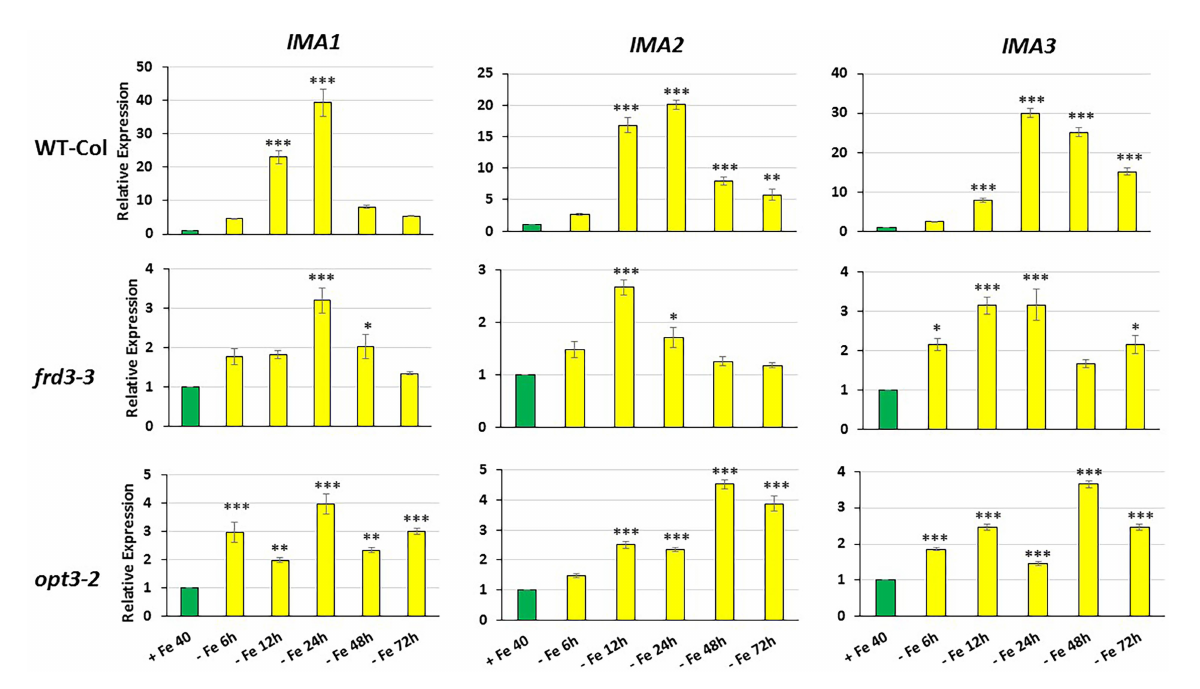
FIGURE 1 Time course of IMA1 , IMA2 and IMA3 expression in roots of Arabidopsis WT Columbia and its LODIS defective mutants frd3-3 and opt3-2 grown under Fe-deficient conditions. Plants were grown in complete nutrient solution. When appropriate, some of them were transferred to complete nutrient solution with 40 μ M Fe-EDDHA (+Fe40) or without Fe (–Fe) for 6, 12, 24, 48 or 72 h. IMA1 , IMA2 and IMA3 relative expression was determined by qRT-PCR. Relative expression was calculated in relation to the +Fe40 treatment. Data represent the mean of 3 independent biological replicates ± S.E. Bars with * , ** or *** indicate significant differences ( p < 0.05, p < 0.01 or p < 0.001, respectively) in relation to the +Fe40 treatment according to the Dunnett’s